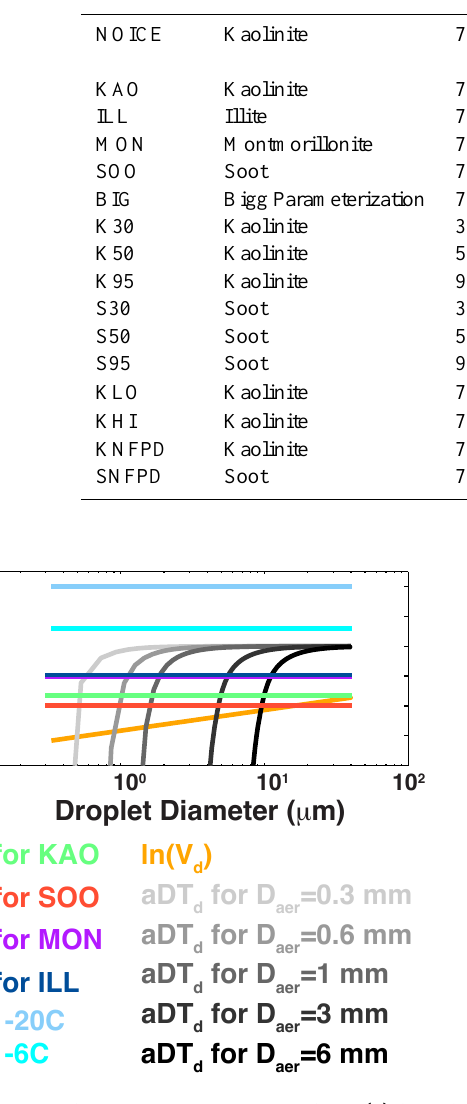
Fig. 1. Contributions of individual components of Eq. (3) for dif- ferent sized liquid droplets. Included are contributions to Y from ln( B h,i ) for aerosols of various compositions (KAO, SOO, MON and ILL), a 1T a for − 20 ◦ C and − 6 ◦ C, ln(V d ), and a 1T d (freez- ing point depression) for droplets formed on aerosol particles with different dry sizes (greyscale lines).